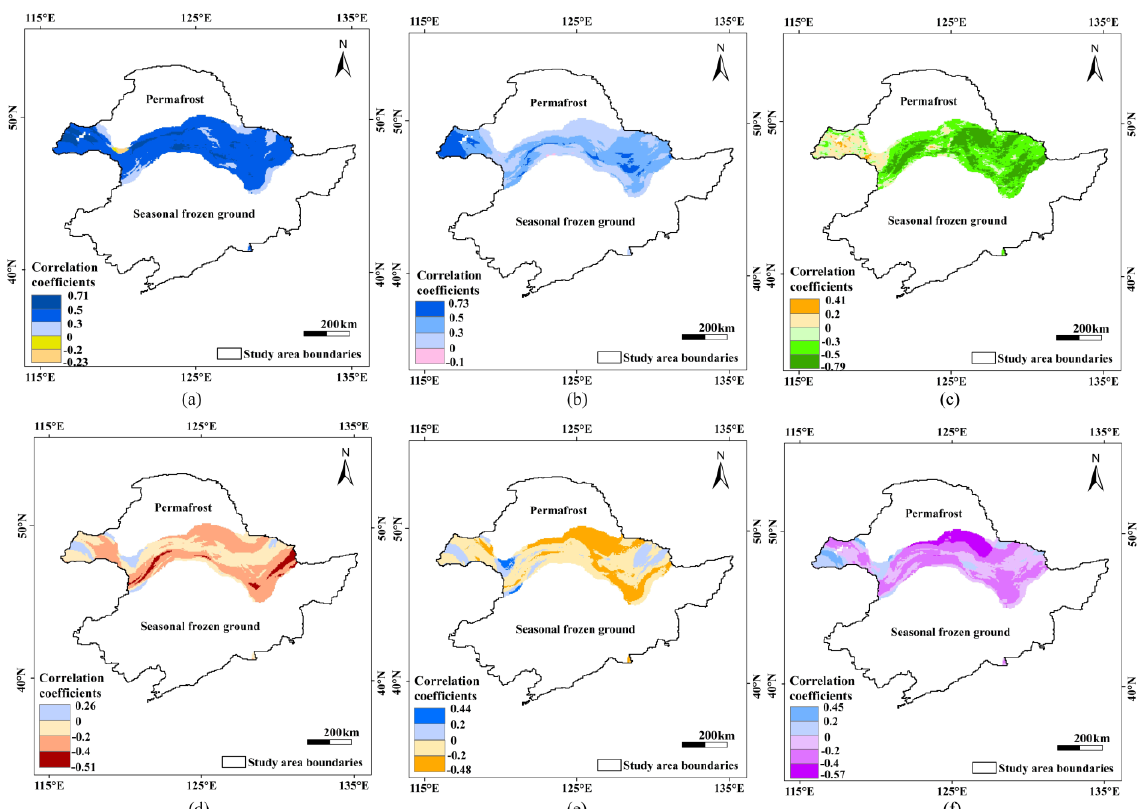
Figure 9. The spatial distributions of the correlation coefficients between permafrost changes and its influencing factors: ( a ) annual average snow cover; ( b ) annual average snow depth; ( c ) annual average NDVI; ( d ) annual average solar radiation; ( e ) annual average precipitation; ( f ) annual average 0 – 7 cm soil water content.